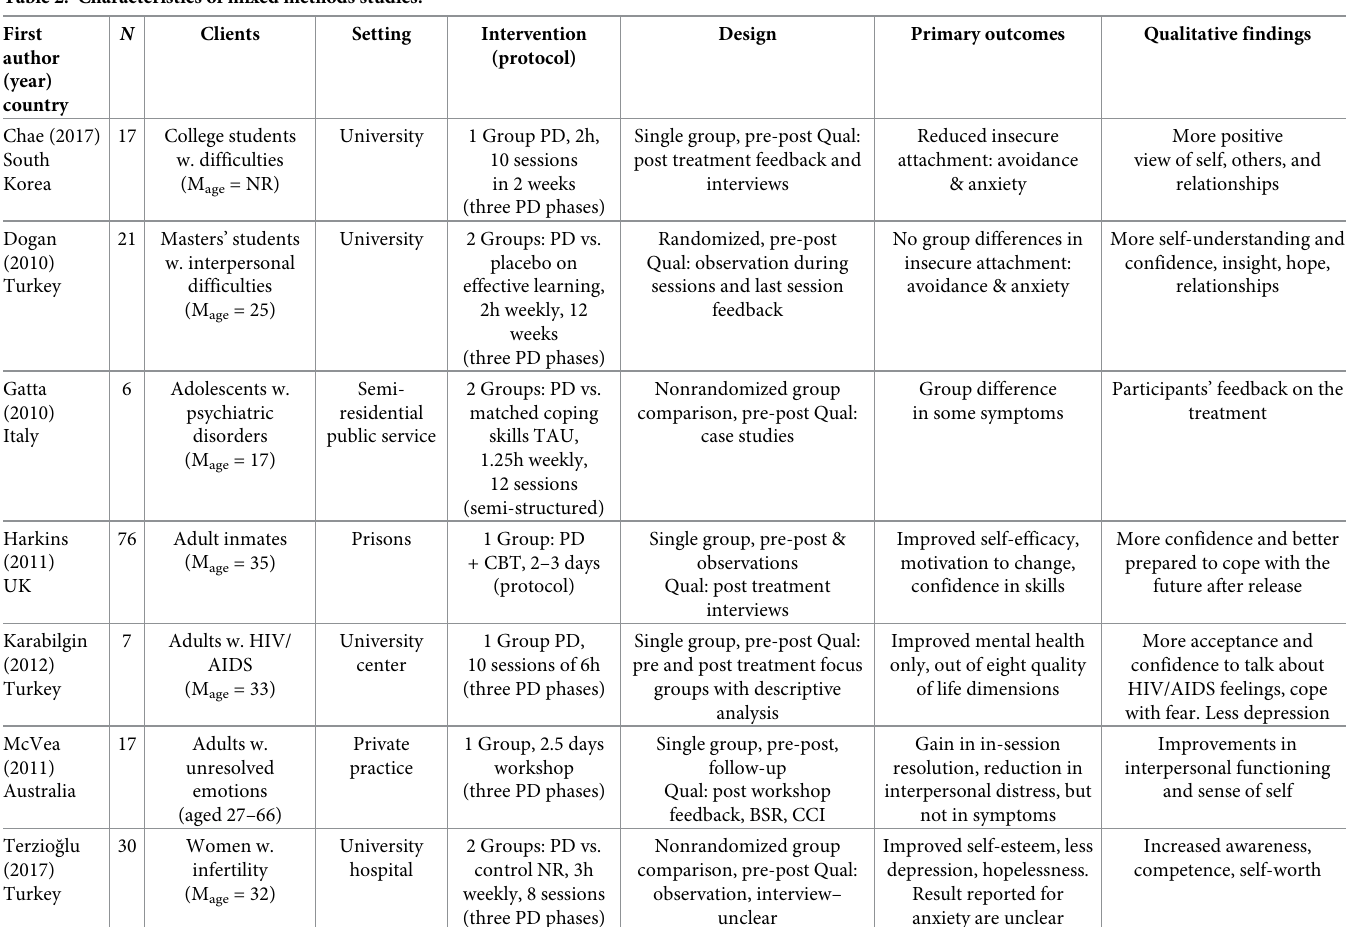
Table 2. Characteristics of mixed methods